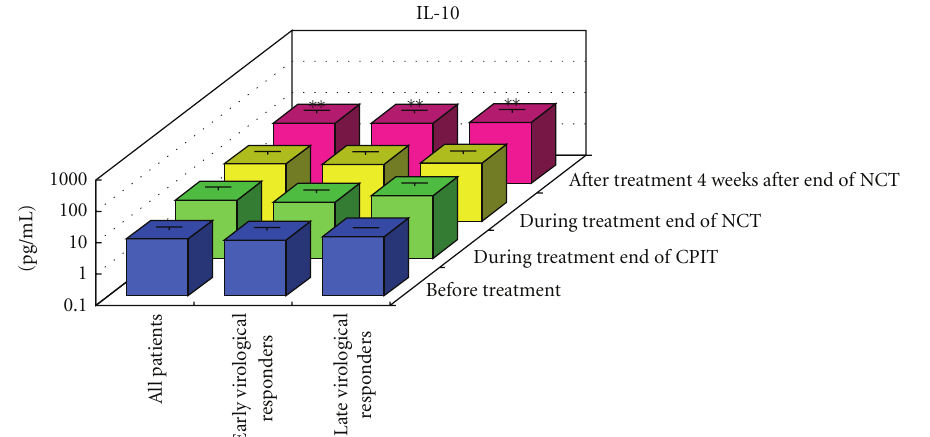
Figure 7: E ff ect of RBV plus PEG-IFN-alpha 2b using an “induction” approach with CPIT (NCT) on serum IL-10 in chronic hepatitis C patients with high viral load, genotype 1b (serotype I), and wild or intermediate type of ISDR. RBV: ribavirin, PEG-IFN: pegylated interferon, CPIT: cyclic and periodic interferon treatment, NCT: novel combination treatment. Significant di ff erence: ∗ P < 0 . 05, ∗∗ P < 0 . 1.